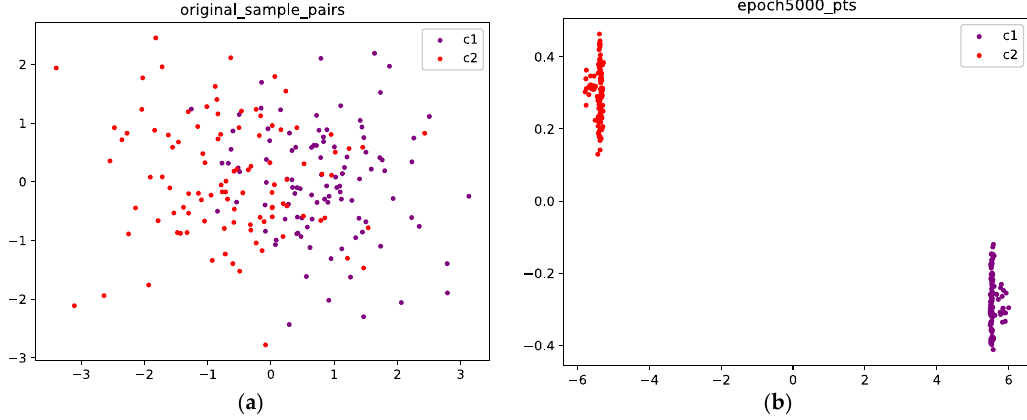
Figure 6. ( a ) The original points are sampled from a Gaussian mixture with two components; the purple points are sampled from class 1, and the red points are sampled from class 2. ( b ) Optimized configuration after 5000 epochs; the points from the two classes are well separated.